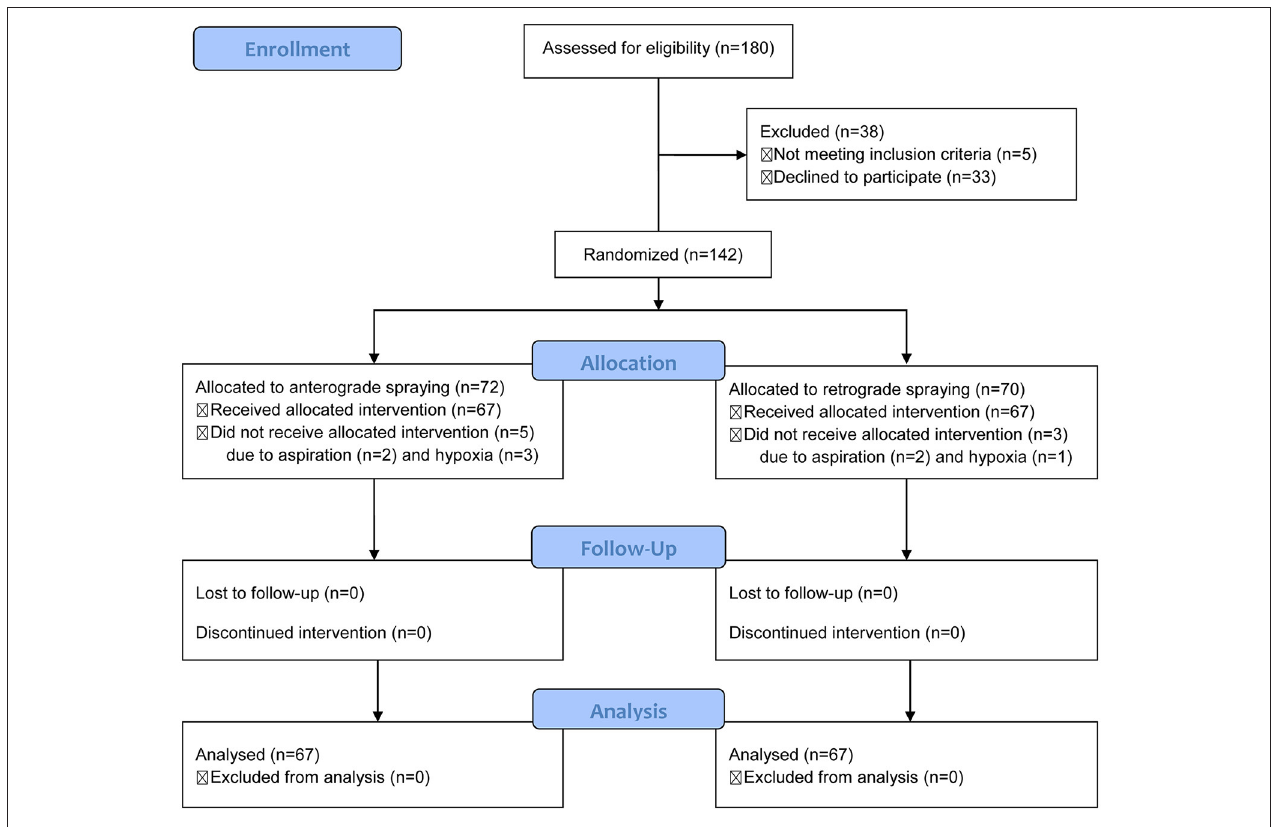
FIGURE 3 | Consort diagram displaying recruitment and patient flow throughout the trial.